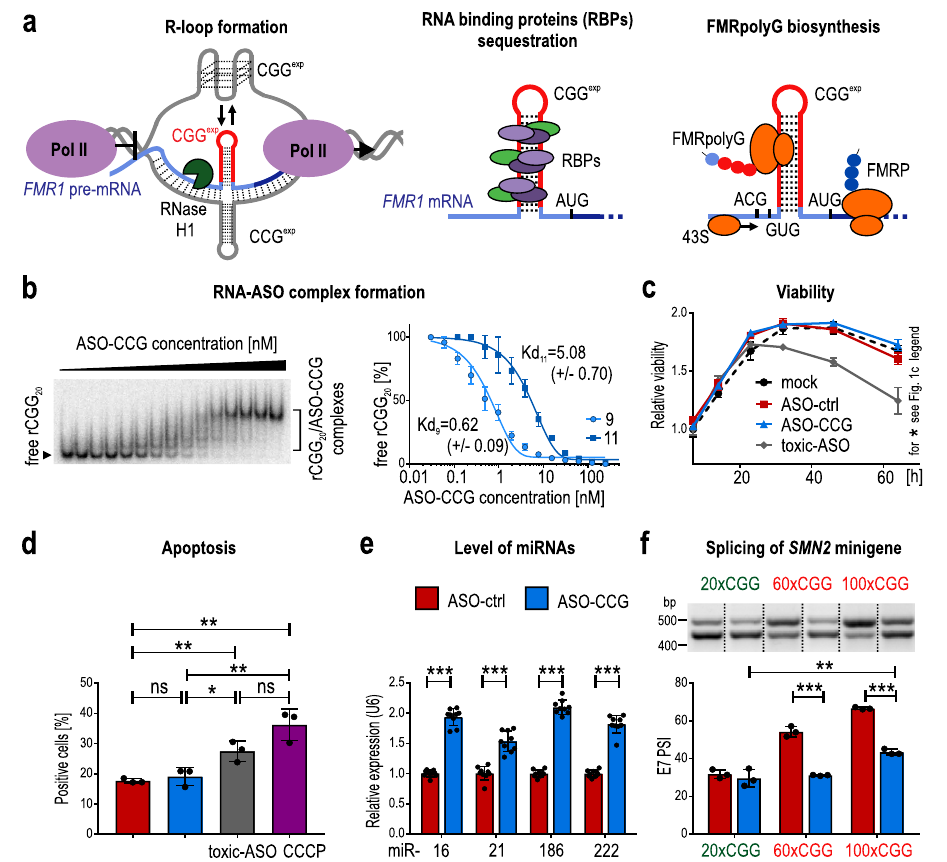
Fig. 1 Binding of ASO – CCG to CGG exp in vitro and in cells reduces the effects of toxic RNA. a Potential molecular pathomechanisms of FXTAS. b EMSA of the interaction of rCGG 20 with ASO – CCGs having 9 and 11 LNA residues. The graph presents means with SDs. N = 3 independent samples for each concentration. Kd, a dissociation constant [nM]. Light blue/dots, 9 nt; dark blue/squares, 11 nt ASO. c In fl uence of ASOs (9 nt, 200 nM) on COS7 cells viability. Graph presents mean of N = 4 biologically independent samples with the SDs. Black/dots, mock (transfection agent); red/squares, ASO-ctrl; blue/tringles, ASO – CCG; dark gray/diamonds, toxic ASO. For 64-h time point: mock vs ASO-ctrl, P = 0.069; mock vs ASO – CCG, P = 0.187; mock vs toxic ASO, P = 0.0004; ASO-ctrl vs ASO – CCG, P = 0.012; ASO-ctrl vs toxic ASO, P = 0.001; ASO – CCG vs toxic ASO, P = 0.0002. d In fl uence of ASOs (9 nt, 200 nM) on apoptosis of COS7 cells. Graph presents mean of N = 3 biologically independent samples with the SDs. Dark gray bar, toxic ASO; purple bar, carbonyl cyanide 3-chlorophenylhydrazone (CCCP, positive control). e RT-qPCR quanti fi cation of the level of endogenous miRNAs in COS7 cells overexpressing rCGG exp and treated with ASOs (9 nt, 200 nM). Graph presents mean of N = 3 biologically independent samples (each with n = 3 technical replicates) with the SDs. f RT-PCR analysis of SAM68-dependent alternative splicing of exon 7 in SMN2 minigene in COS7 cells overexpressing normal (green) or expanded CGG repeats (red) and treated with ASOs (11 nt, 200 nM). Graph presents mean of N = 3 biologically independent samples with the SDs. 100×CGG ASO-ctrl vs 100×CGG ASO – CCG, P = 0.00002. The upper bands, the exon 7 inclusion isoforms; the lower bands, the exon 7 exclusion isoforms. PSI, the percent of spliced in. b , f Samples were derived from the same experiment and processed in parallel on different gels. Presented gels were cropped. d – f Red bars, ASO-ctrl; blue bars, ASO – CCG. c – f Two-sided, unpaired Student ’ s t test; * P < 0.05; ** P < 0.01; *** P < 0.001; ns, non-signi fi cant. b – f Source data are provided as a Source Data fi